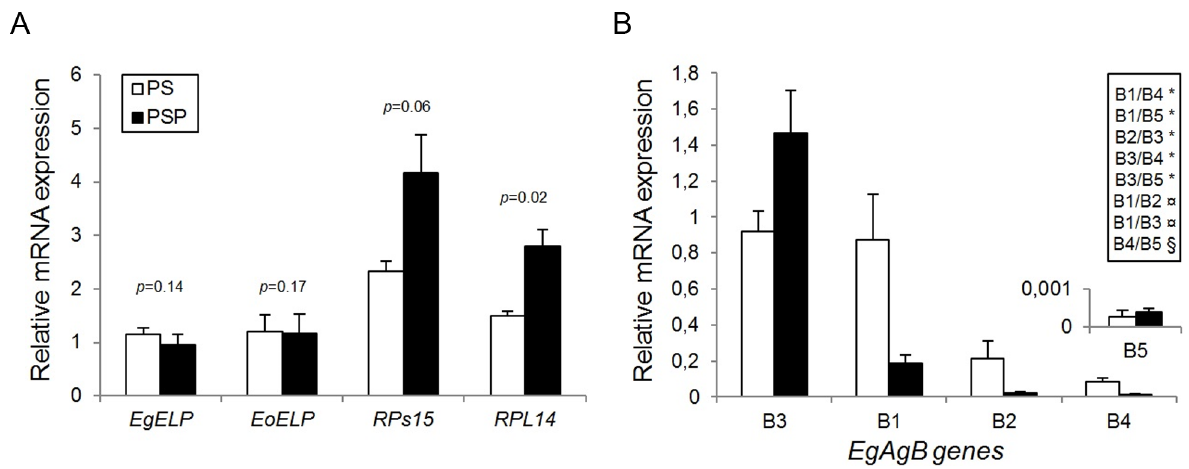
Figure 3. Relative mRNA expression of the selected target genes using EF-1 a as reference gene. The constitutive ( ELP ) and differential ( RPs15 and RPL14 ) gene expression between both PS and PSP conditions are shown in (A). Here, the PS treatment of the EgELP gene was used as calibrator to obtain the 2 2 DD CT values and, subsequently, the bar graph bar. E. ortleppi was used only for the ELP gene ( EoELP ) expression analysis, and E. granulosus was used to analyze the ELP gene ( EgELP ) and all other target genes. Results for the EgAgB1-5 genes (B) are consistent with previous works in Echinococcus spp. [8,21], where EgAgB1 and EgAgB3 are the most abundant in protoscoleces, and EgAgB5 exhibit a very low gene expression. The increase of EgAgB1 and the decline of EgAgB2 , EgAgB3 and EgAgB4 genes in the PSP group is comparable to previously described for the immature adult form of E. multilocularis [21]. The statistical significance between EgAgB subunits in both PS and PSP groups (*) as well as only for PSP (¤) or only for PS ( 1 ) are shown in the inset. Here, the PS treatment of the EgAgB3 subunit was used as a calibrator. A significance level of a =0.05 was considered. Figure S2 Amplification specificity of the primers. A single band was observed for each amplicon in the 2% agarose gel (top). The melting curves obtained for each gene (below the agarose gel) also show a specific curve without any contaminants. (TIF) Figure S3 Amplification curves used to calculate the amplification efficiency for each selected gene. Numbers from 1 to 7 (in red color) indicate the dilutions that were used for the amplification efficiency calculation of the candidate reference genes. (TIF) Table S1 RefFinder output tables for E. ortleppi . Based on three random samplings of 3 paired samples of E. ortleppi , the results obtained (A, B and C) were similar to those in the E.